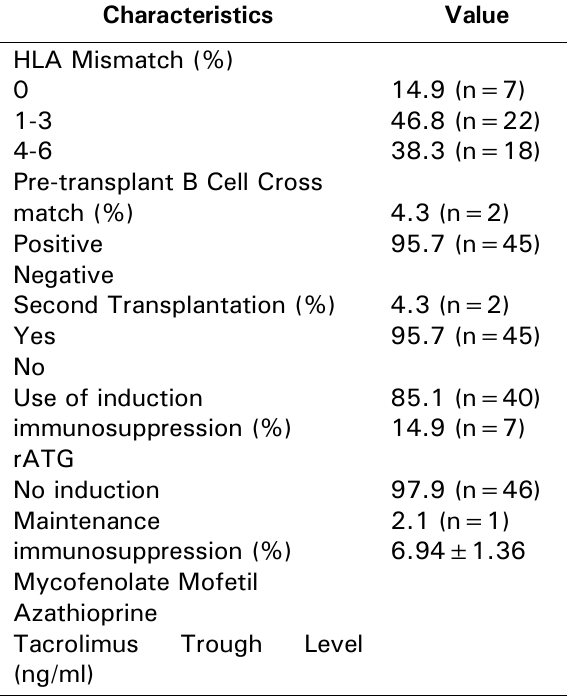
Table.2. Immunological characteristics of